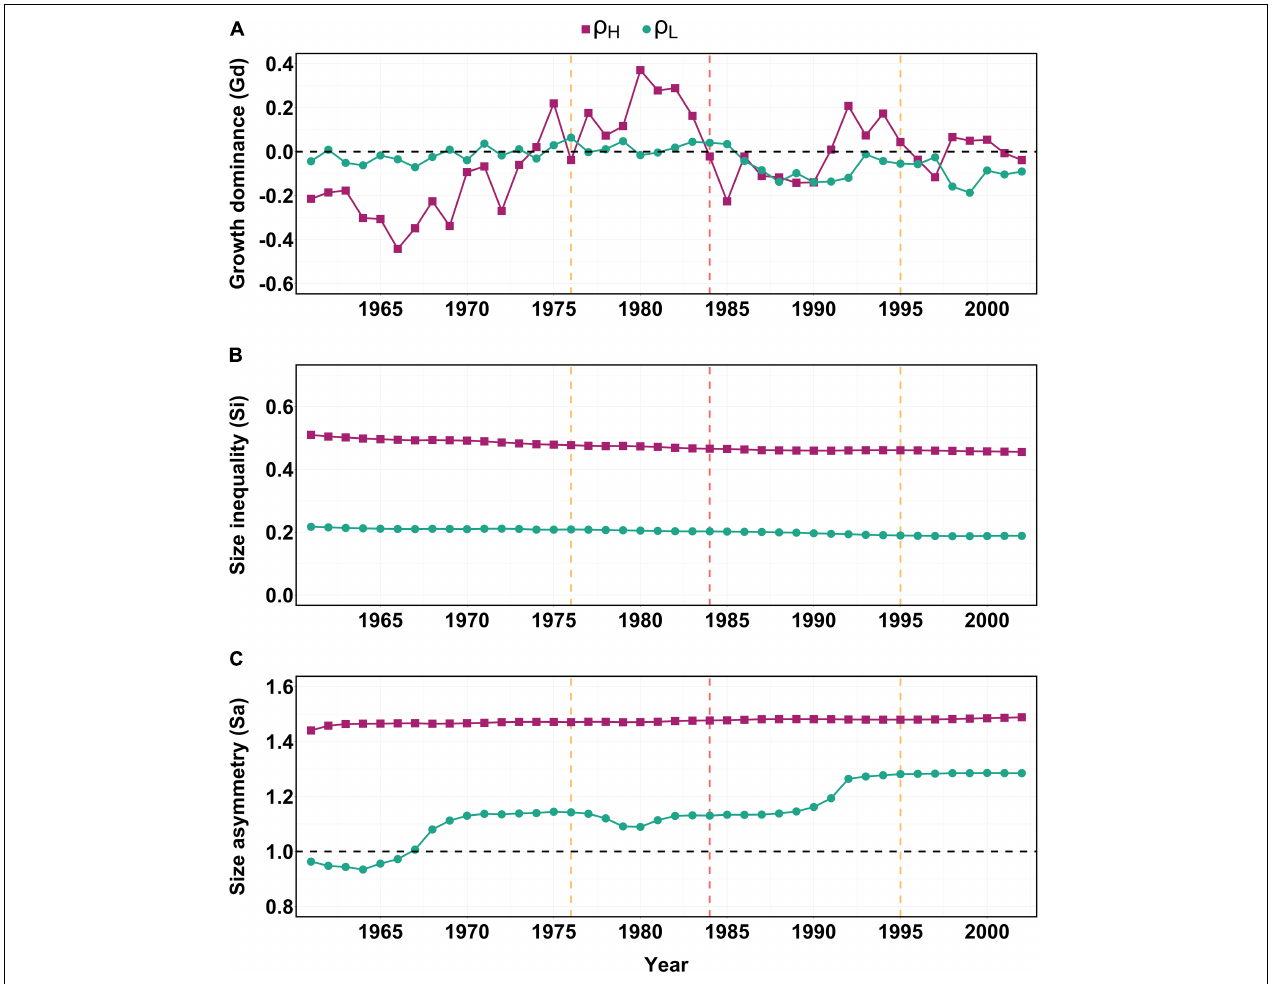
FIGURE 4 | Annual values for (A) Growth dominance ( G d ), (B) Size inequality ( S i ), and (C) Size asymmetry ( S a ) calculated annually for both high ( ρ H ) and low ( ρ L ) density treatments. The horizontal black line in (A) indicates that all trees are growing at rates directly proportional to their size, positive values indicate larger trees are dominating growth relative to their size while negative values indicate smaller trees are dominating growth relative to their size in a given year. The dashed horizontal line in (C) indicates both large and small trees are contributing equally to tree size inequality while values > 1 or < 1 indicate larger or smaller sized trees are contributing more to size inequality, respectively. Orange vertical dashed lines indicate the 1976 and 1995 droughts, while the red vertical dashed line indicates the 1984 drought. Purple squares represent ρ H (high density) n = 29 , while green circles represent ρ L (low density) n = 27 .